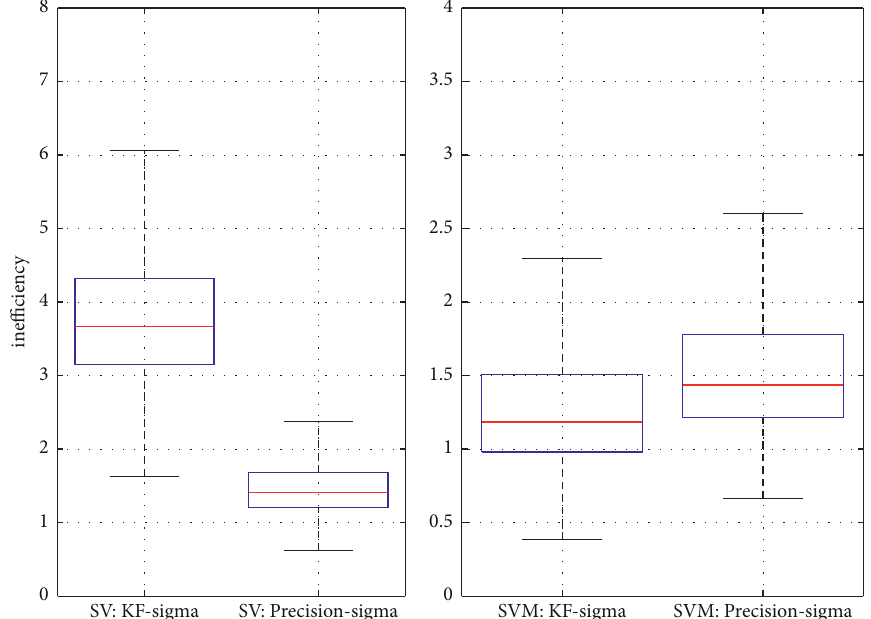
Figure 3: The inefficiency factor boxplots of the posterior draws σ in the SV model and the SVM